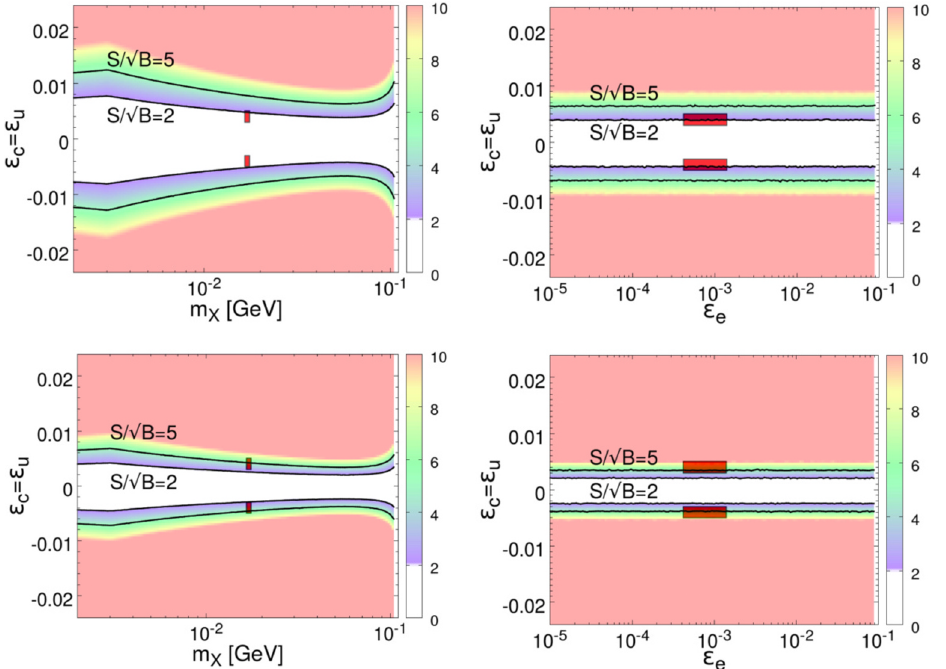
√ B on ( m X , ε c ) and ( ε c , ε e ) planes from J/ Ψ → η c e + e − light X = 10 10 (upper panels) and N J/ Ψ from table 1, and the invariant mass cut | M c